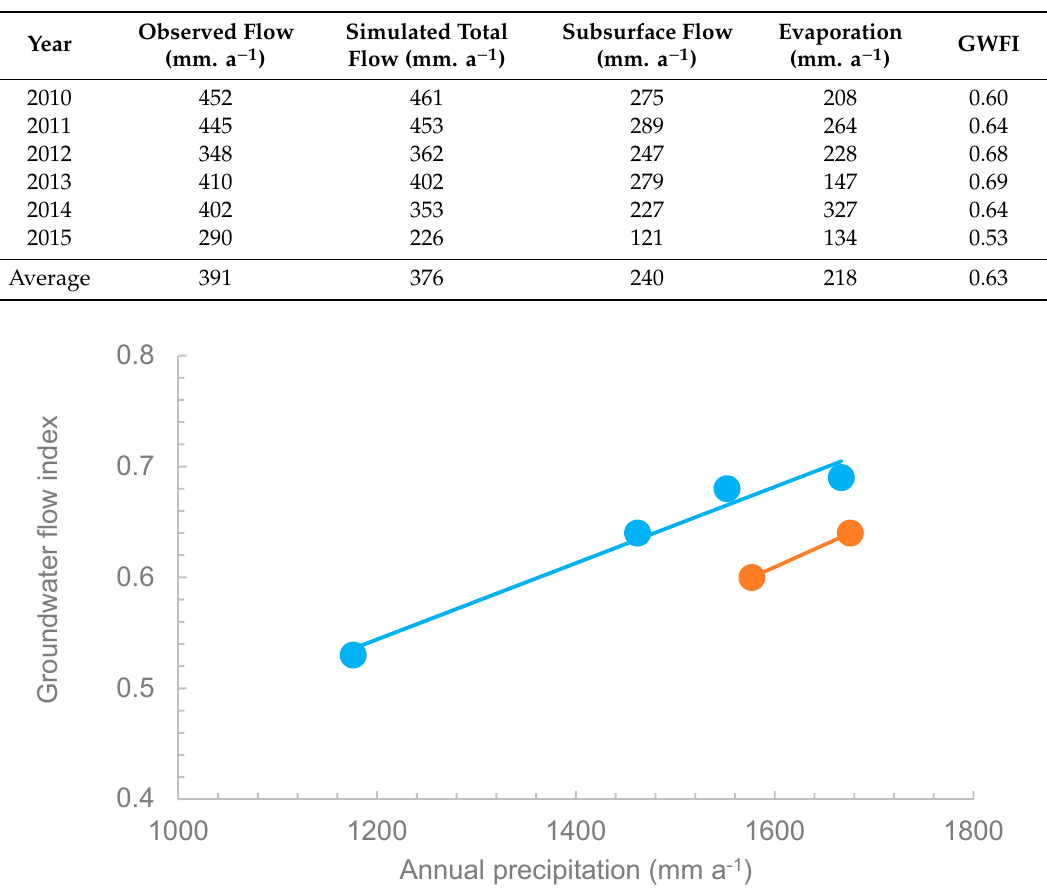
Table 4. Groundwater flow index (GWFI) for the period 2010–2015 based on hydrological model results of the Tikur-Wuha watershed. Note that the amounts are given as a volume of the contributing area to the gauge divided by the total area of the watershed. In 2015, the data represent the period from 15